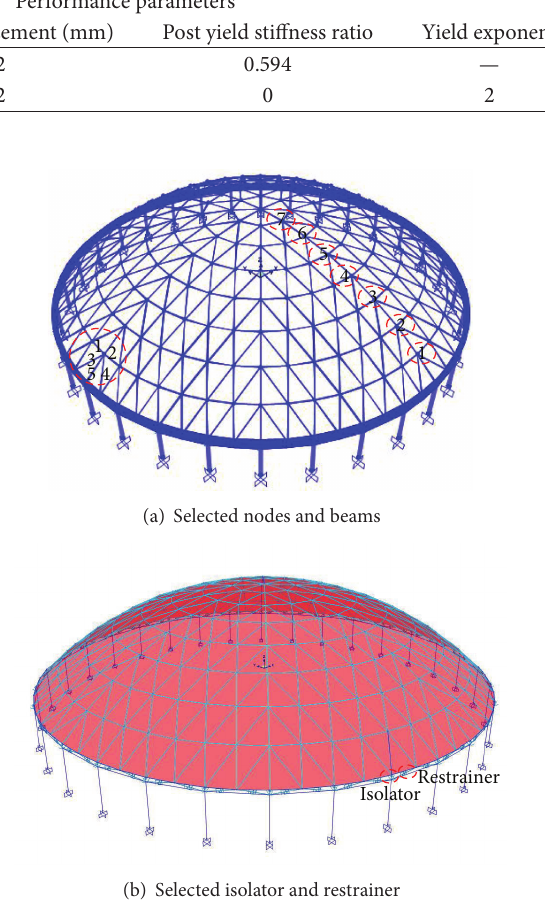
Figure 9: Selected nodes and elements in the lattice